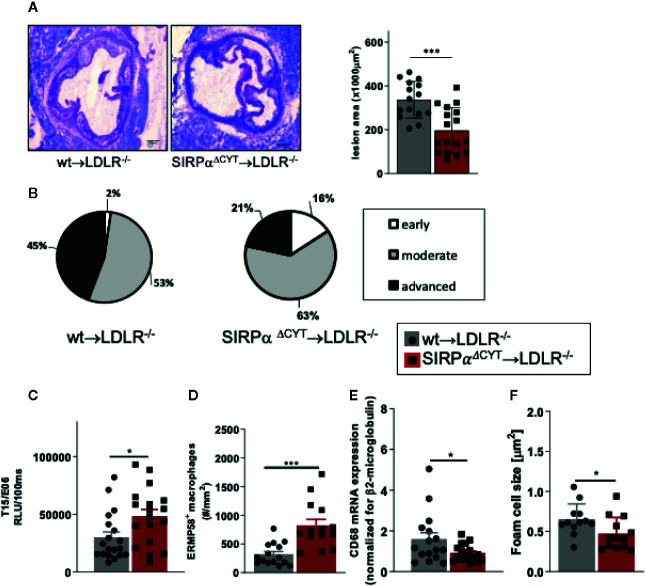
Loss of SIRPα signaling protects mice from atherosclerosis. (A, B) Bone marrow chimeras carrying dysfunctional SIRPα in their hematopoietic compartment are protected from atherosclerosis, showing (A) smaller and (B) less severe aortic lesions. (C) Atheroprotection in SIRPαΔCYT>LDLR−/− chimeras is associated with increased levels of oxLDL-targeting natural antibody T15/E06 in plasma. (D–F) Atherosclerotic lesions of SIRPαΔCYT>LDLR−/− chimeras contain more small macrophages (D), less CD68+ macrophages (E), and a smaller foam cell area (F) as compared to wt chimeras. Data are presented as mean ± SEM and are representative of 15-17 (A, B), 18-19 (C), and 12-16 (D–F) individual mice. Statistical analysis was performed by unpaired Student t-test used per variable, corrected for multiple comparisons with Holm-Sedak method, *p < 0.05; ***p < 0.001 or Chi-square test (B), *p < 0.05.